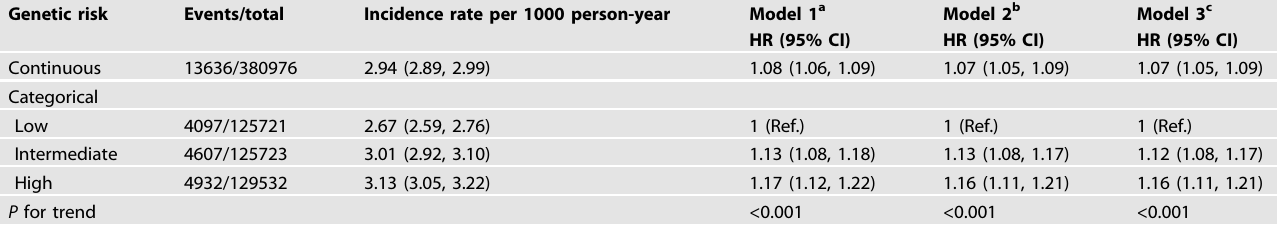
Table 3. Risk of incident depression according to genetic risk.